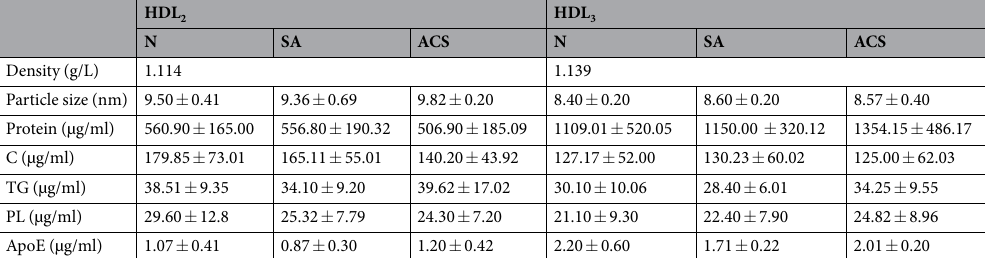
Table 3. Characteristic parameters of HDL 2 and HDL 3 subfractions isolated from sera of normal subjects (N), stable angina patients (SA) and acute coronary syndrome (ACS) patients. N - healthy normal subjects, SA - stable angina patients, and ACS - acute coronary syndrome patients; C - cholesterol, TG - triglycerides, PL - phospholipids, ApoE - apolipoprotein E. Data are expressed as means ± SD and analyzed with Independent Student’s T-test (n =